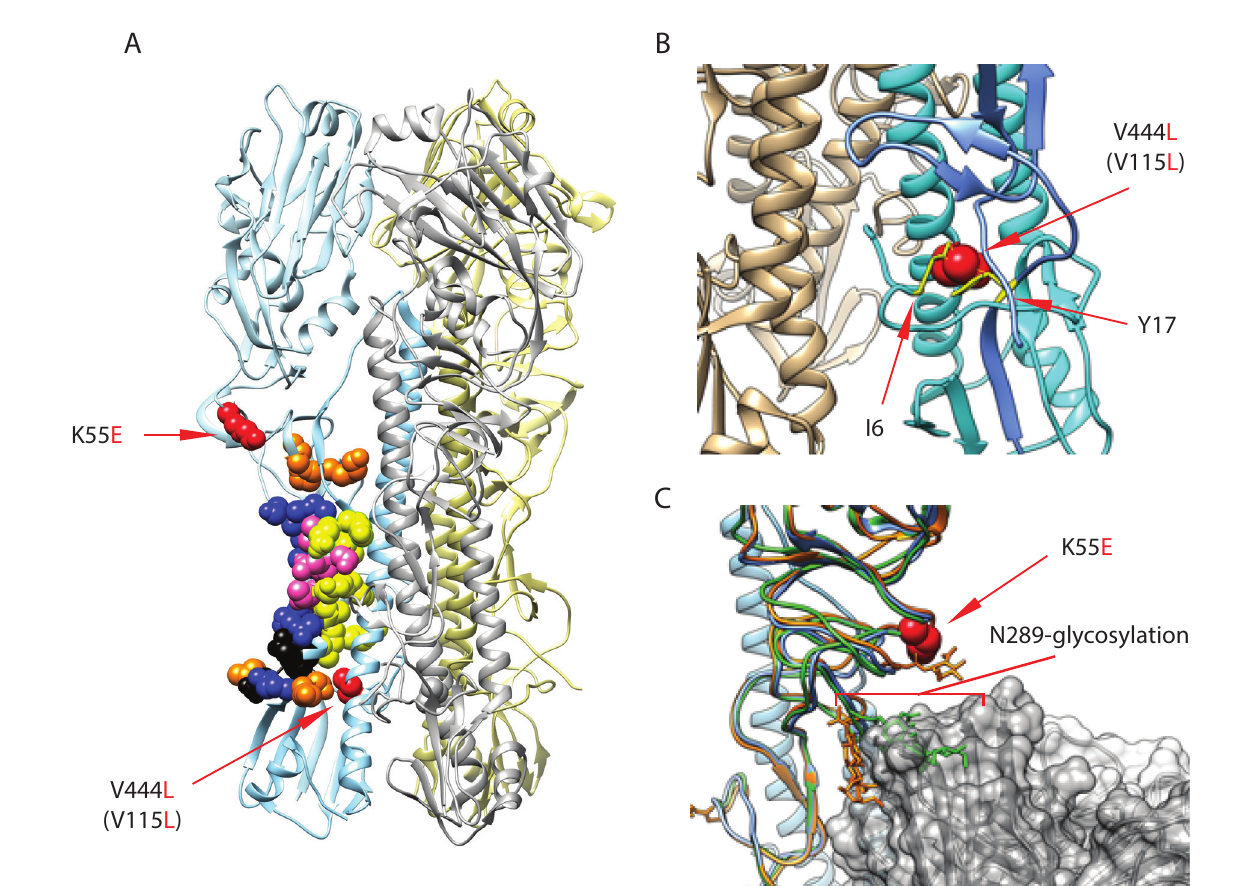
Fig 5. Stem antibody epitopes and MAb 4C2 resistance mutations. (A) The localization of stem antibody epitopes and MAb 4C2 escape mutations in A/Puerto Rico/8/1934 HA trimer is shown. PDB: 1RU7. Yellow: C179 epitopes; Blue: CR6261 epitopes; Orange: FI6 epitopes; Pink: C179 and CR6261 overlap epitopes; Black: CR6261 and FI6 overlap epitopes; Red: MAb 4C2 escape mutations. (B) The changes of mutation V444L (V115L, HA2 numbering) in stem region. V444L (V115L) (red) is in HA2 helix B. The V to L substitution results in van der Waals clashes with residues I6 (HA2) and Y17 (HA1), colored in yellow. (C) The changes of mutation K55E in stem region. K55E (red) is located within a loop region containing HA1 residues 42–58 and 263–314. This region also includes N-linked glycosylation site N289, which has the potential to interfere with stem Ab binding. Shown is MAb FI6 (grey) and aligned HA1 structures from H1 –blue (1RU7), H1+FI6 – orange (3ZTN), and H2 –green (4HLZ). Alignment of HA1 causes N289-glycosylation to clash with the bound antibody in some conformations (green), but not others